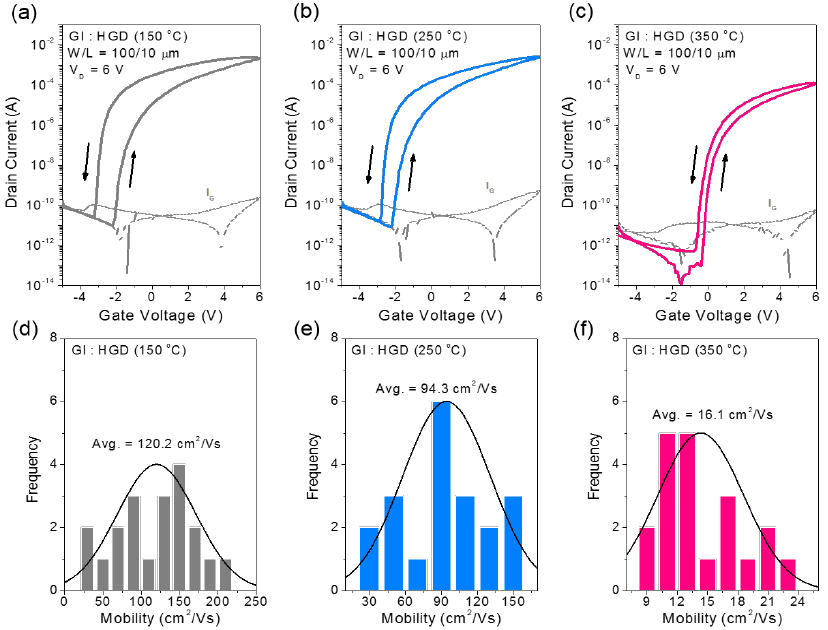
Figure 4. Electrical characteristics of various solution-processed InO x TFTs on an HGD dielectric layer for the different processed conditions. The transfer curves for InO x TFTs with ( a ) 150 °C-annealed; ( b ) 250 °C-annealed; and ( c ) 350 °C-annealed HGD films. The dotted lines indicate the gate leakage current. Statistical distribution of field-effect mobilities for InO x TFTs with ( d ) 150 °C-annealed; ( e ) 250 °C-annealed; and ( f ) 350 °C-annealed HGD films.